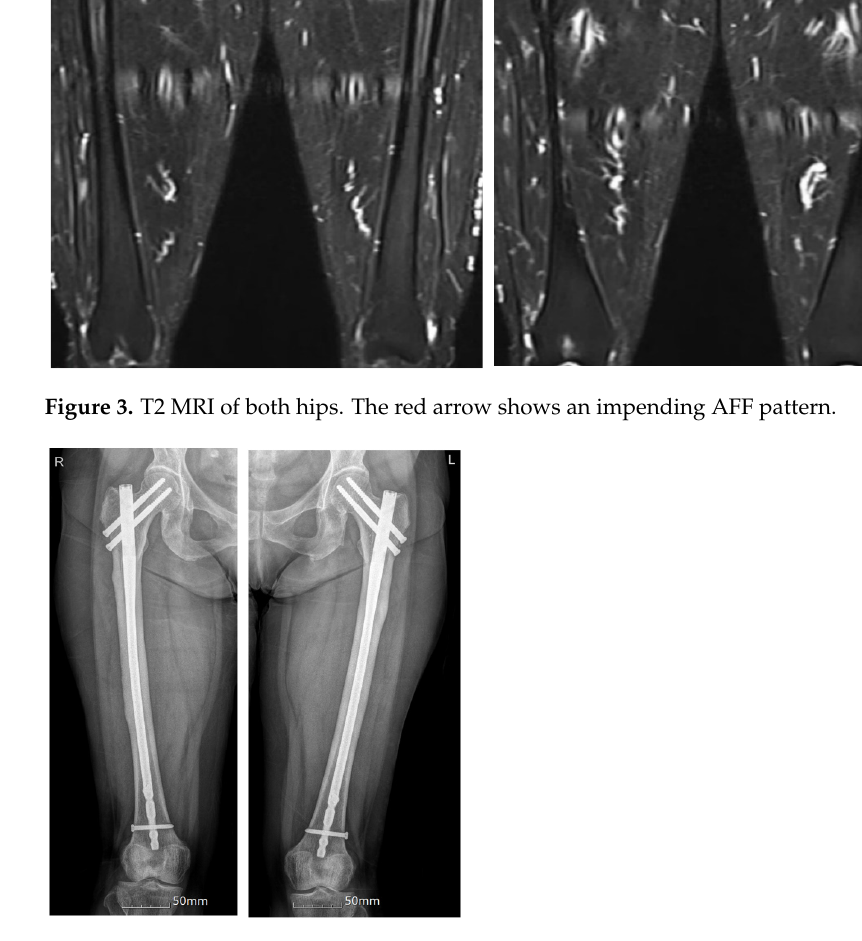
Figure 4. X-ray taken after prophylactic trochanteric femoral nailing.